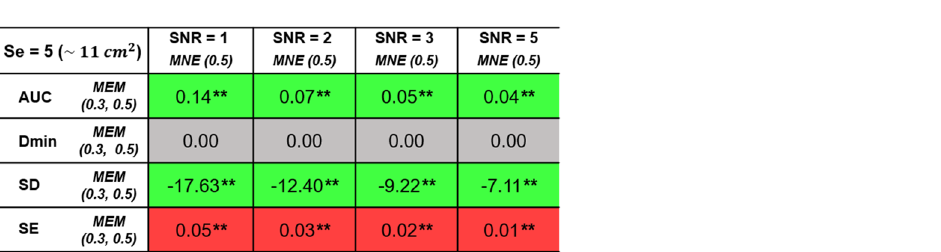
Figure 6. Evaluation of the performances of MEM and MNE at four different SNR levels. Boxplot representation of the distribution of four validation metrics for MEM(0.3, 0.5) and MNE(0.5) involving superficial seeds with spatial extent Se = 5 . SNR levels ( SNR = 1, 2, 3, 5 ) are represented using different colors. Figure created by MATLAB version (R2016a) https:// www. mathw orks. com/ produ cts/ matlab. html.